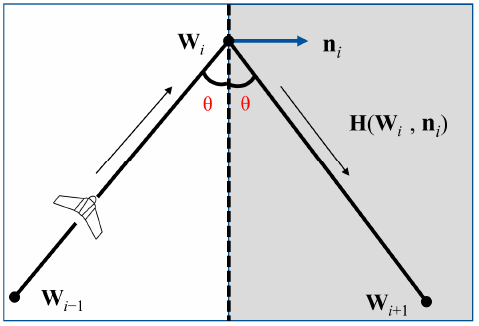
Figure 27. Results of following an orbit path by the combined guidance law: ( a ) flight trajectory; ( b ) distance error.